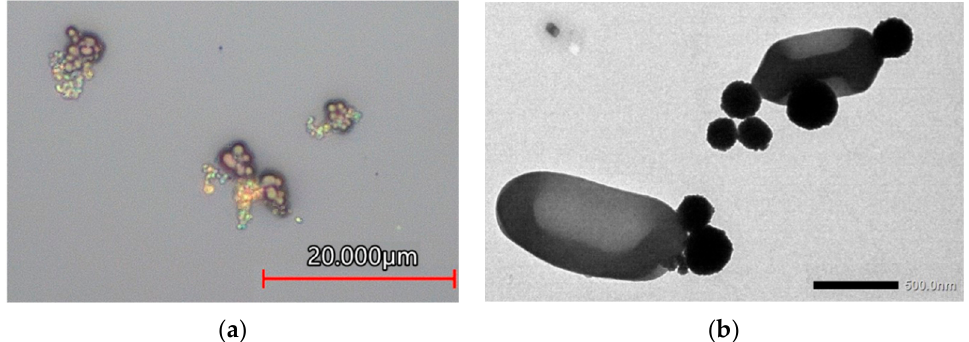
Figure 1. ( a ) Confocal laser microscope image of multiple MNPs bound to clusters of S. aureus cells; ( b ) TEM image of multiple MNPs bound to L. monocytogenes cells.